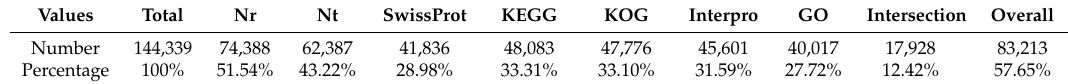
Table 3. Table of alignment results for the seven